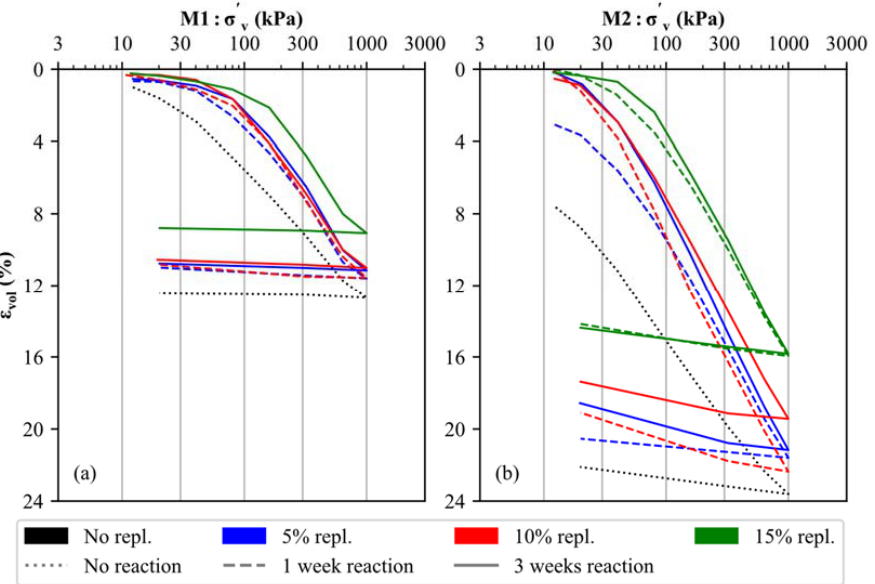
Figure 5. Results of oedometer tests executed on uncemented and artificially cemented soil specimens: ( a ) M1 and ( b ) M2 .